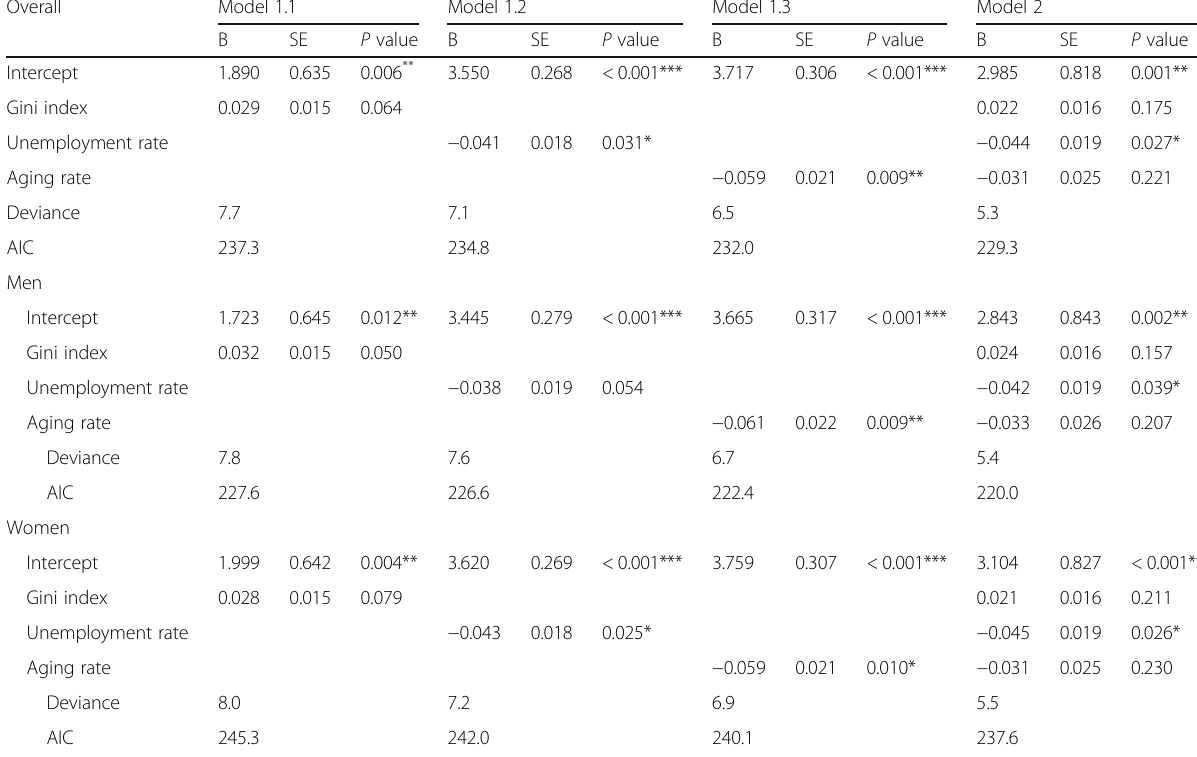
Table 4 Generalized linear model with the prevalence of TCAM practitioner usage controlled by GDP per capita ( N =